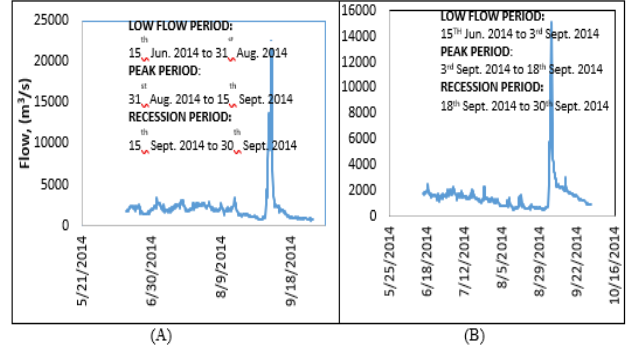
Fig. 7. Classification of flow periods on the observed hydrograph at (a) Maralla station (b) Mangla station (15 th June 2014 to 30 th September